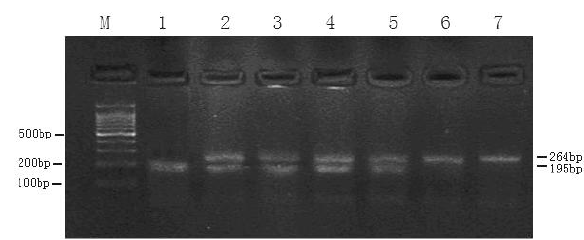
Figure 1. Representative HaeIII restriction fragment pattern of 316 bp IGFBP-3 gene fragment in cashmere goats. Lane M, molecular size marker (100 bp DNA ladder); Lanes 1: BB genotype (195, 69, 44 and 8 bp); Lane 2-5: AB genotype (264, 195, 69, 44 and 8 bp); Lane 6 and 7: AA genotype (264, 44 and 8